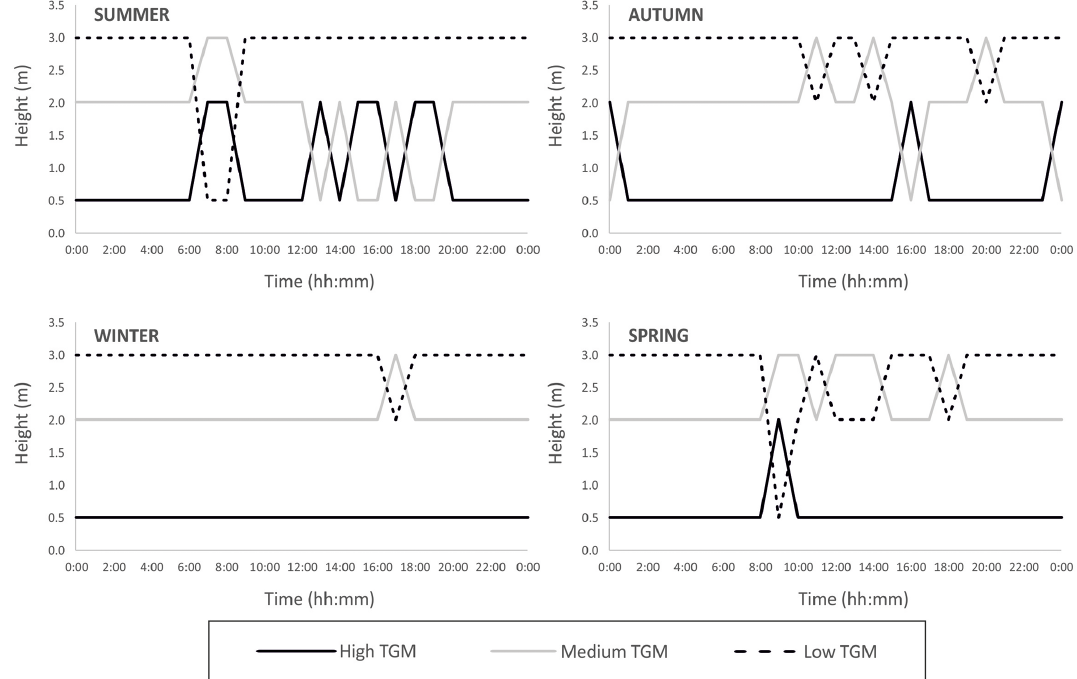
Figure 3. Schematic representation of the daily evolution of the maximum, medium and minimum levels of gaseous Hg at the three measuring points in the vertical